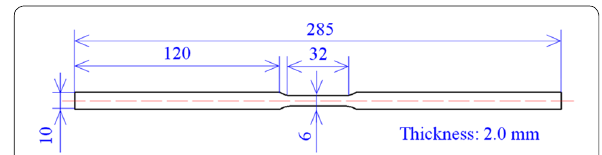
Figure 1 Dimensions of modified specimen in uniaxial tensile testing